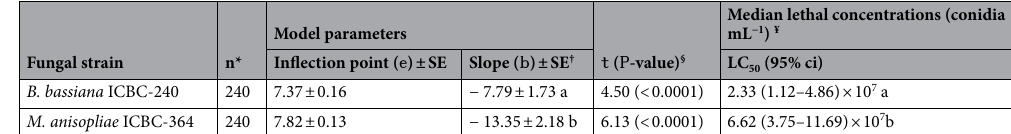
Table 1. Two-parameter log-logistic model fitted to concentration-mortality data for describing the virulence of two fungal strains to G. platensis adults in terms of their estimated median lethal concentrations (LC 50 ) with corresponding 95% confidence intervals. Concentration is expressed as conidia mL -1 . *Total number of insects in the experiment. † Slope for mortality represents regression of proportion of weevils versus log (concentration) of conidia. Different letters indicate significant contrast between slopes according to Student t-test ( P < 0.05). § Student t-test and P -values represent the probability of slope ≠ 0. ¥ Student t-test contrasts for estimated lethal concentrations indicate significant differences when followed by distinct letters at P <